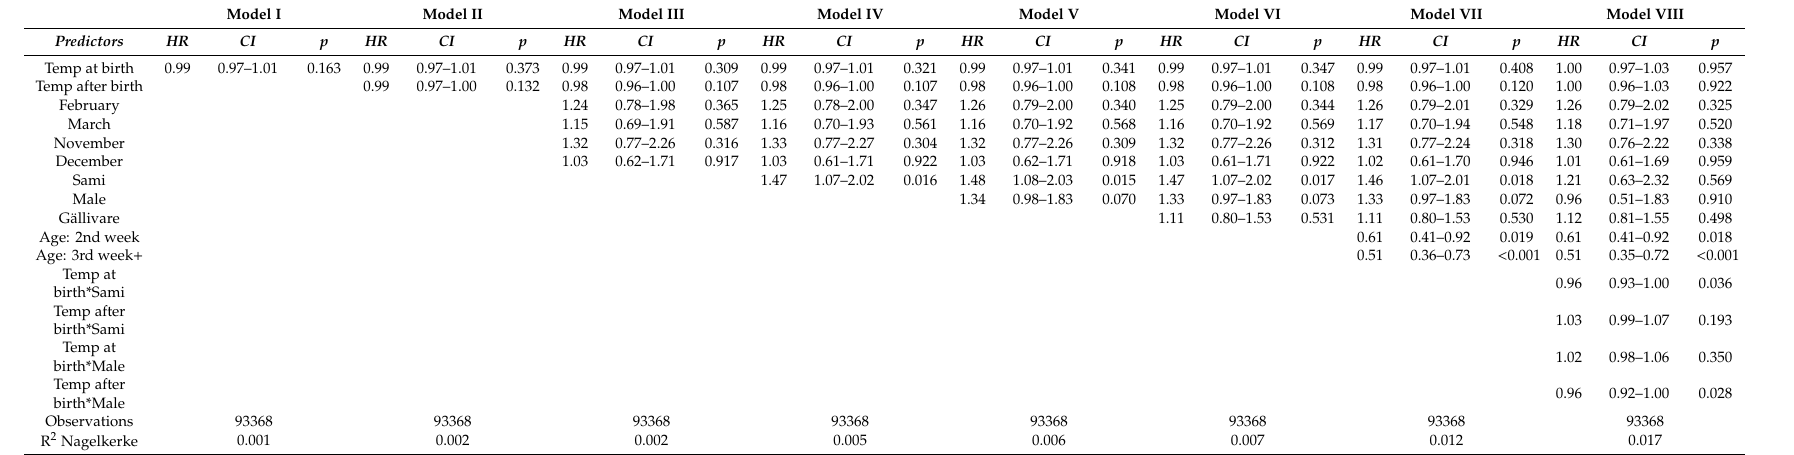
Table A2. Discrete time regression models of neonatal mortality by temperature, with interactions sex*temperature and ethnicity*temperature, expressed as hazard ratios, confidence intervals (CI 95%) and p , cold seasons (November–March),